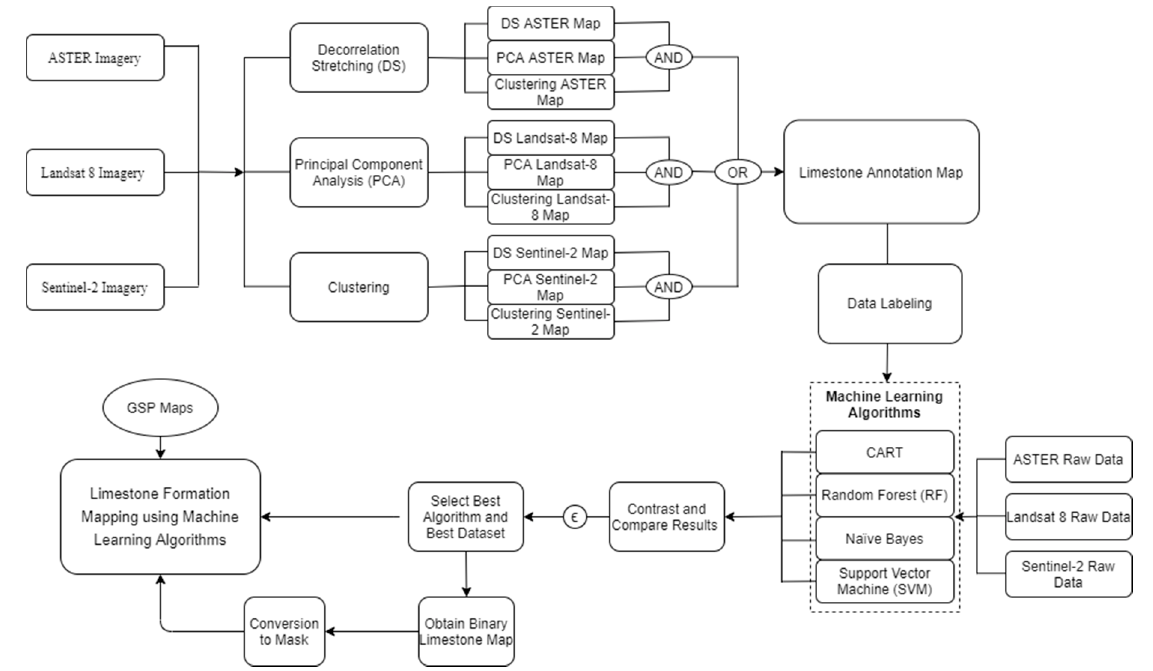
Figure 2. Methodology of the study showing the process of image fusion and data annotation, supervised classification using three data sources for limestone and limestone formations mapping of Hazara District, Pakistan.